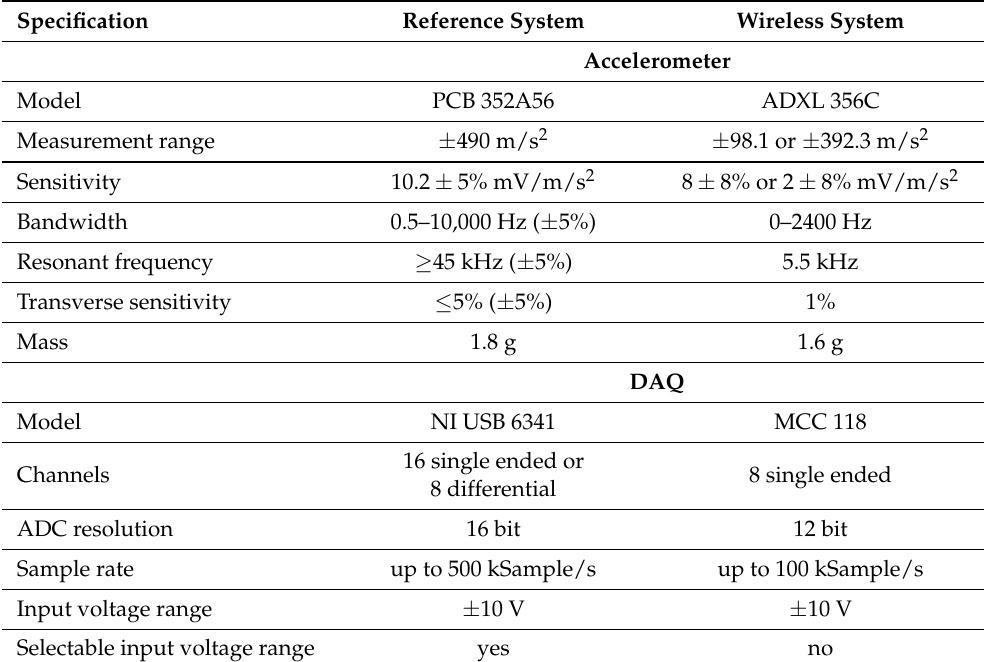
Table 2. Main specifications of both the acceleration measurement